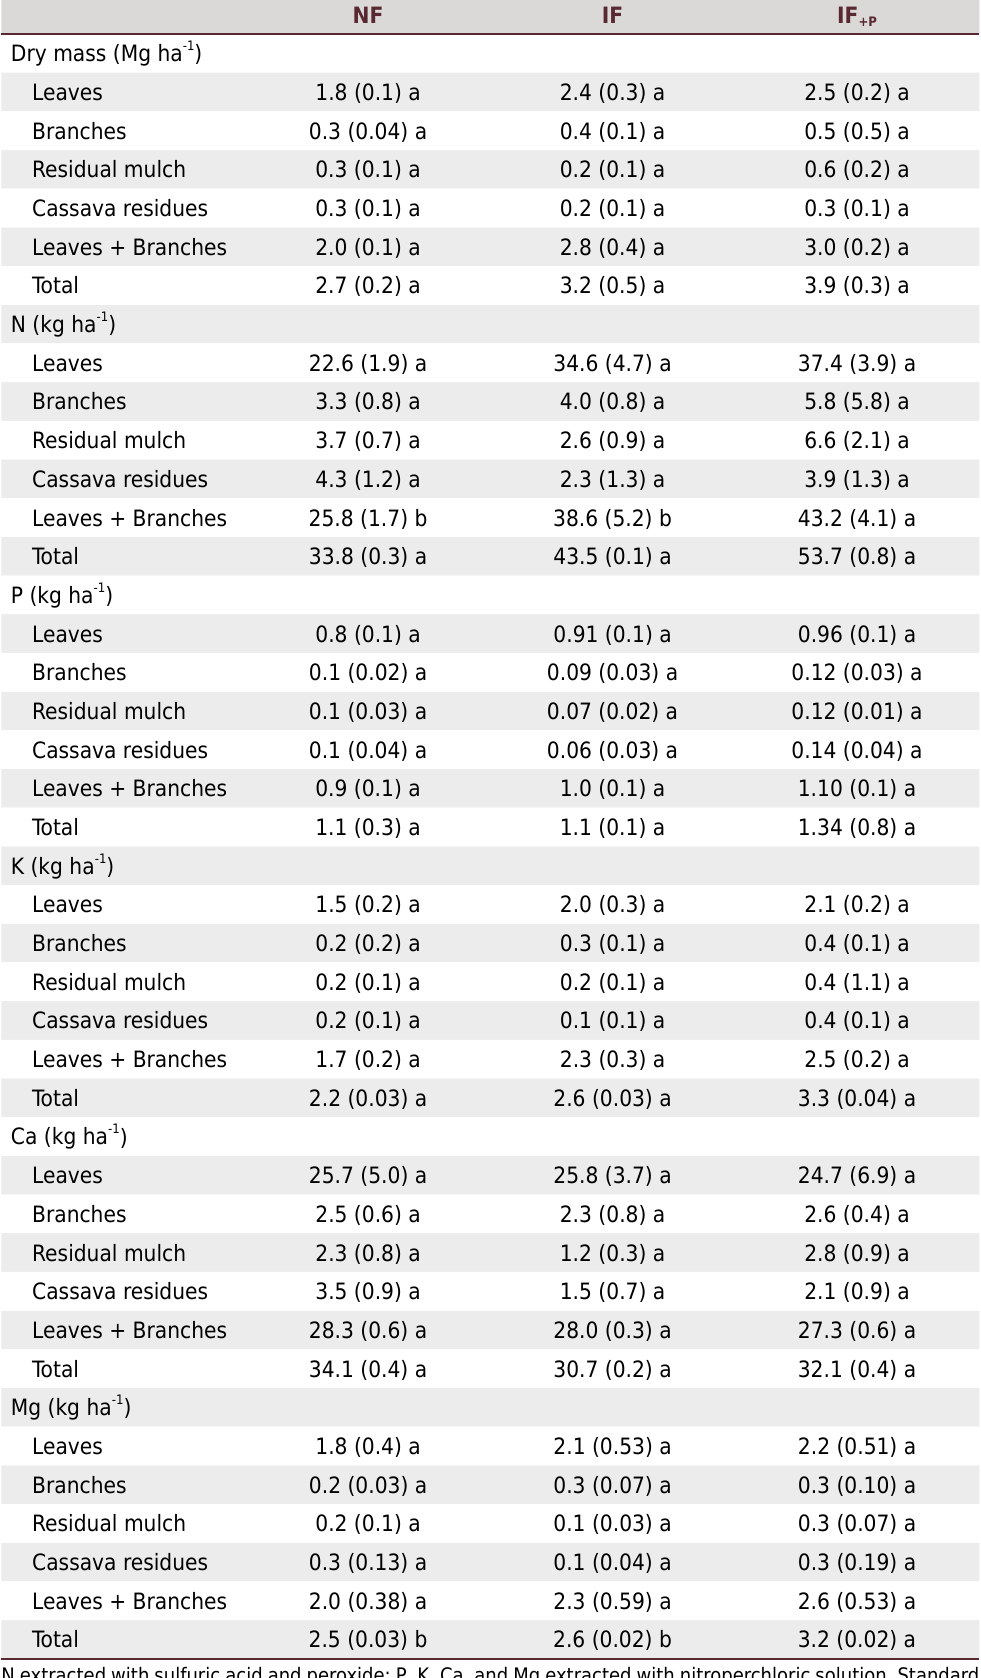
Table 4. Dry mass and nutrient stocks in the litter layer after 23 months of natural fallow (NF), improved fallow (IF), and improved fallow with P fertilization (IF +P ) in Marapanim, eastern